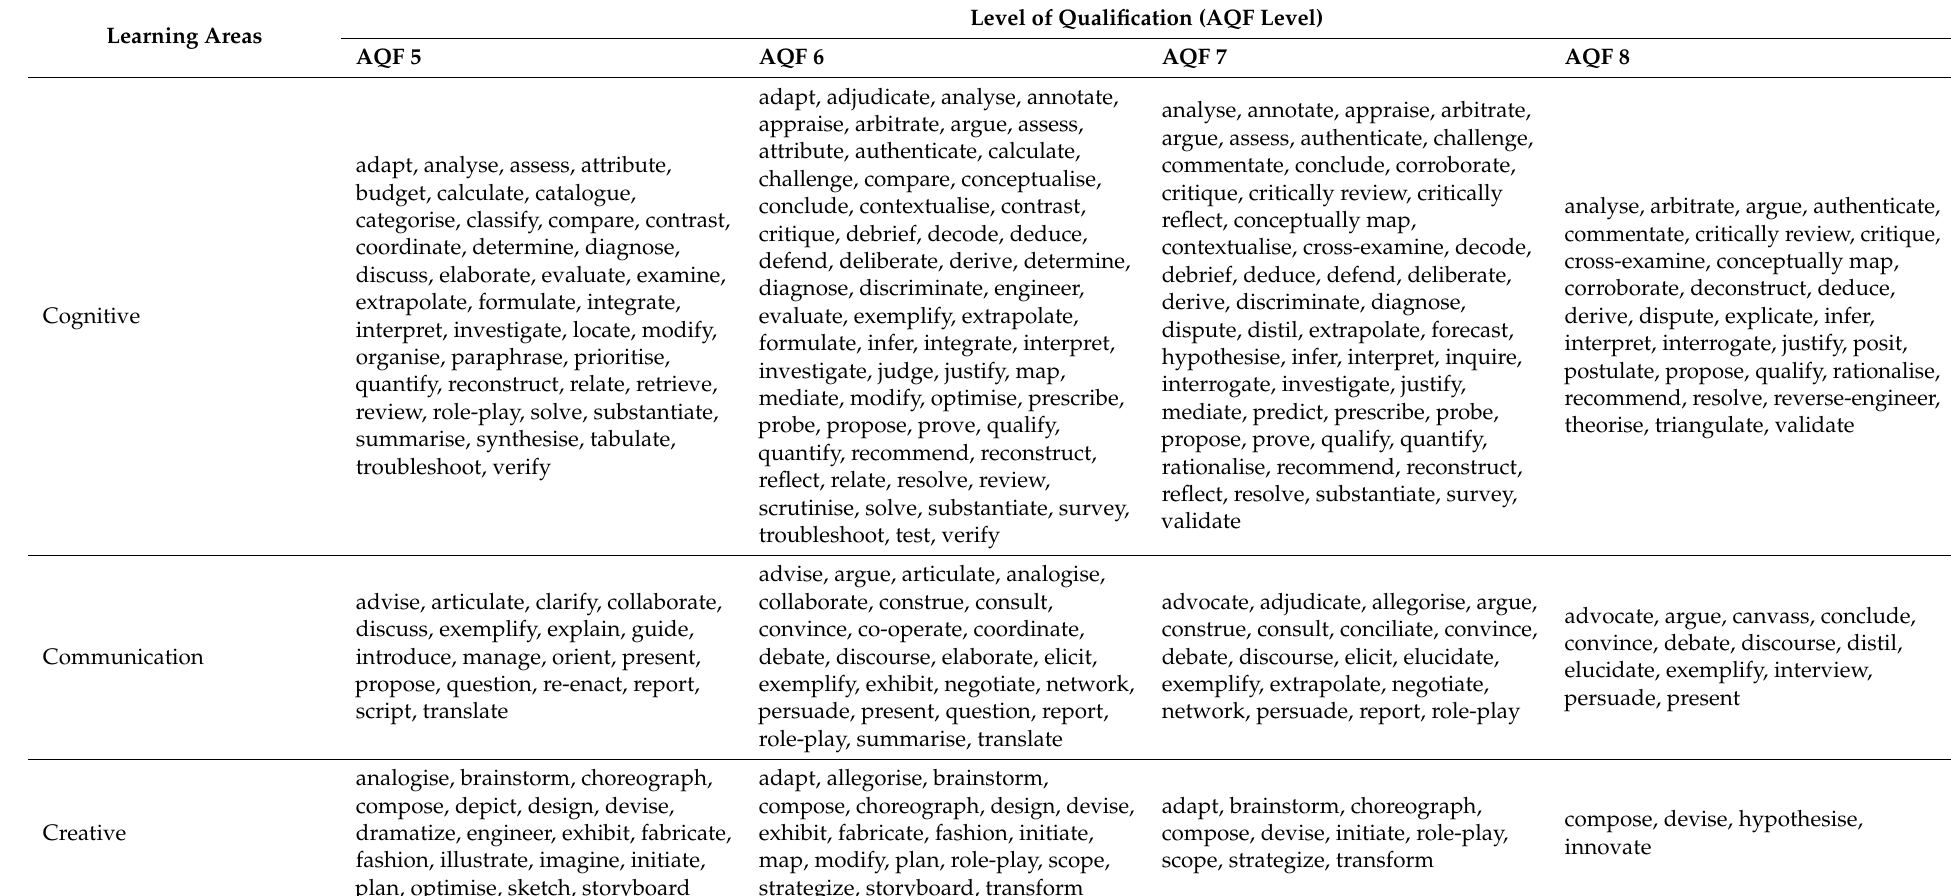
Table 4. Matrix representation of learning outcome verbs corresponding to AQF levels and learning areas [47]. Learning